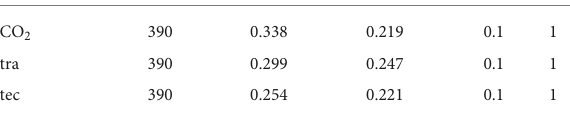
TABLE 1 Descriptive statistics of variables.